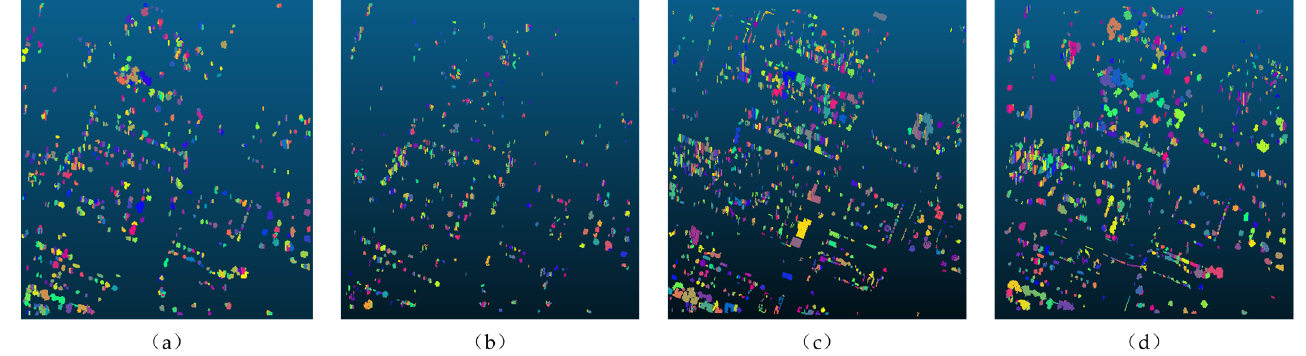
Figure 11. ( a ) Lidar-detected trees (hyperspectral point cloud data), ( b ) lidar-detected trees (532 nm channel lidar data), ( c ) lidar-detected trees (1064 nm channel lidar data), ( d ) lidar-detected trees (1550 nm channel lidar data).